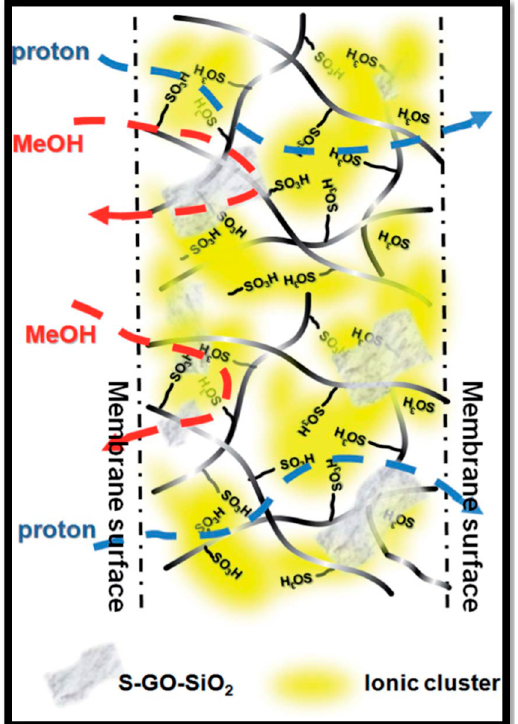
Figure 10. Schematic illustration of proton and methanol transport in S-GO–SiO 2 / Nafion ® composite membrane. Reproduced from [48], with permission from Royal Society of Chemistry, 2014.